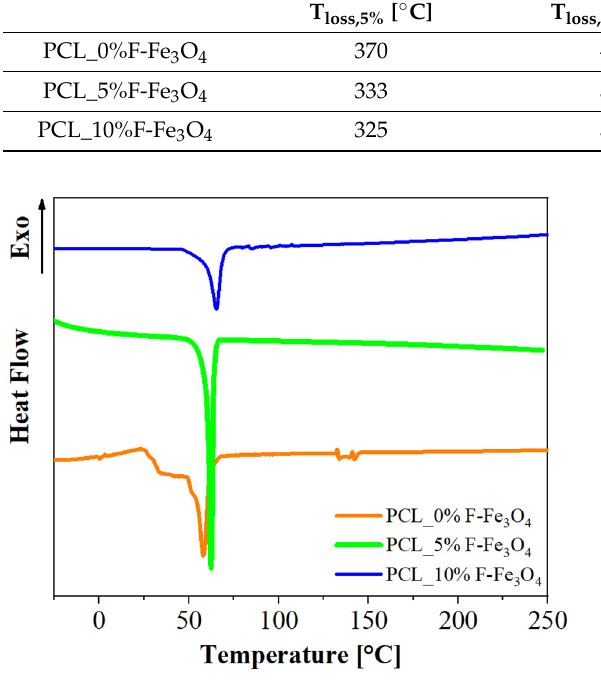
Figure 2. DSC curves of PCL membranes loaded with F-Fe 3 O 4 .